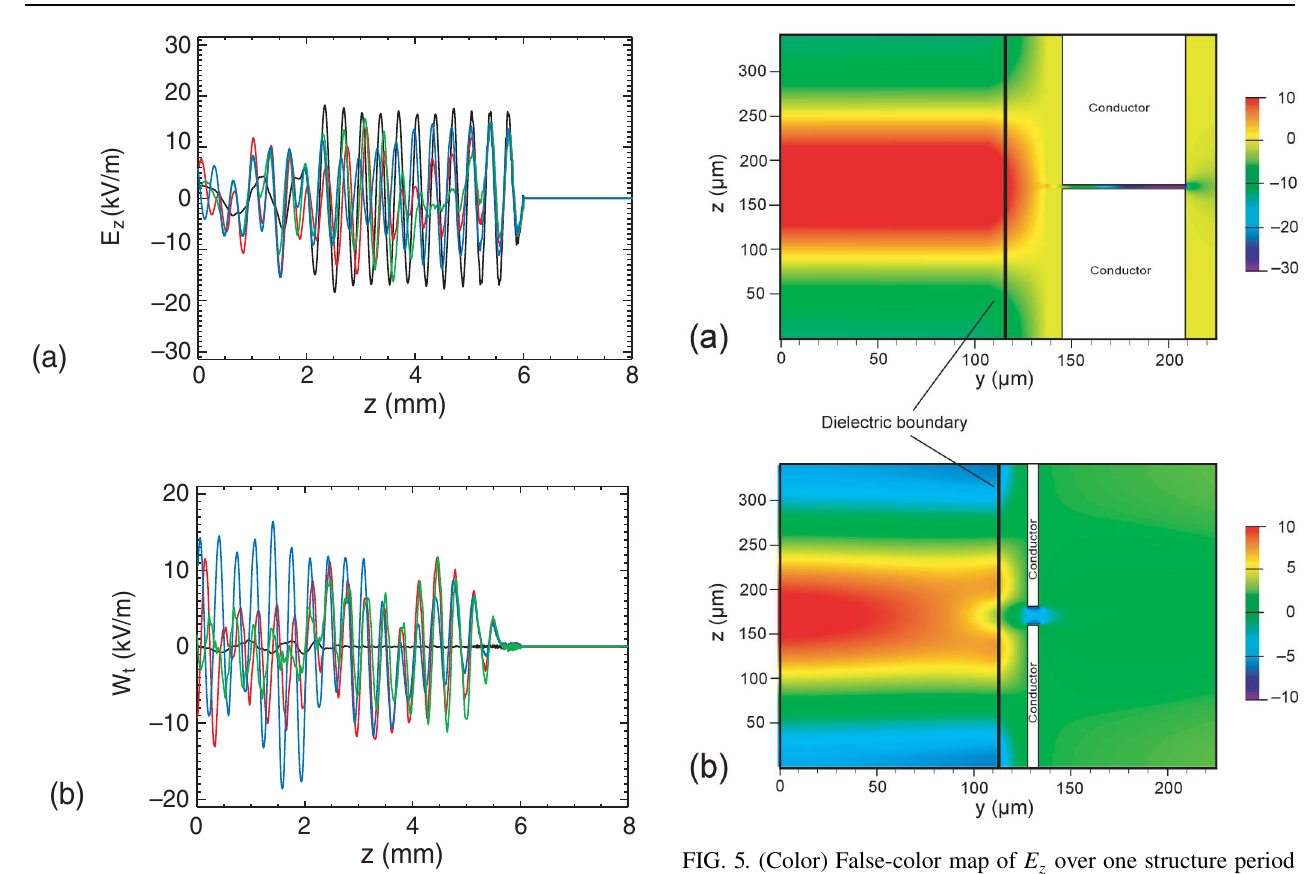
FIG. 5. (Color) False-color map of E over one structure period z in z , for slab-symmetric structures with (a) quarter-wave slots, = 4 , and (b) short slots ( (cid:1) (cid:1) 5 (cid:2) m (cid:10) (cid:1) = 4 ), (cid:1) (cid:1) 69 (cid:2) m (cid:11) (cid:1) g g with dimensions given in Table I. Only the half-plane above the symmetry axis at y (cid:1) 0 is shown. Field strengths are in relative